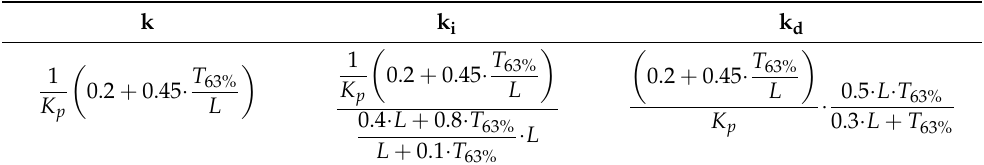
Table 3. Summary of values for k, k i , and k d according to the lambda method. k k i k d 1 K p